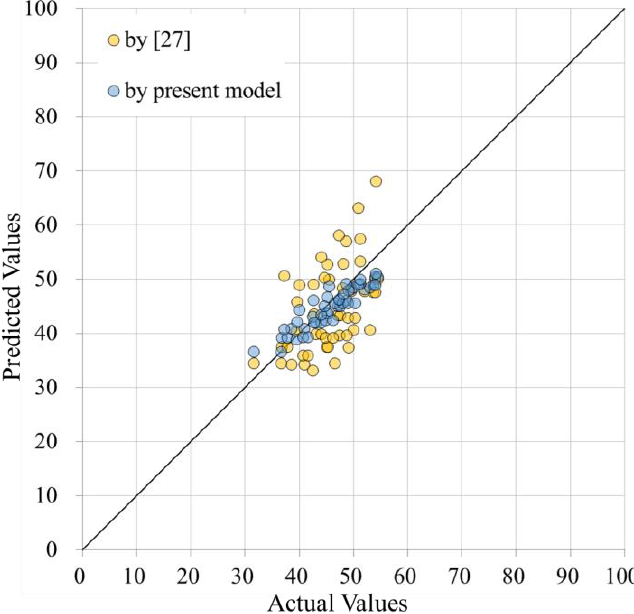
Figure 5. Comparison of the predicted values with the actual 28-day compressive strength of con- crete in which no fly ash was admixed [25] (Unit: MPa).